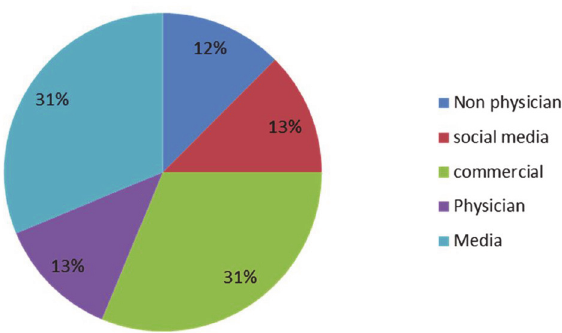
Fig 2. Description distribution of the websites